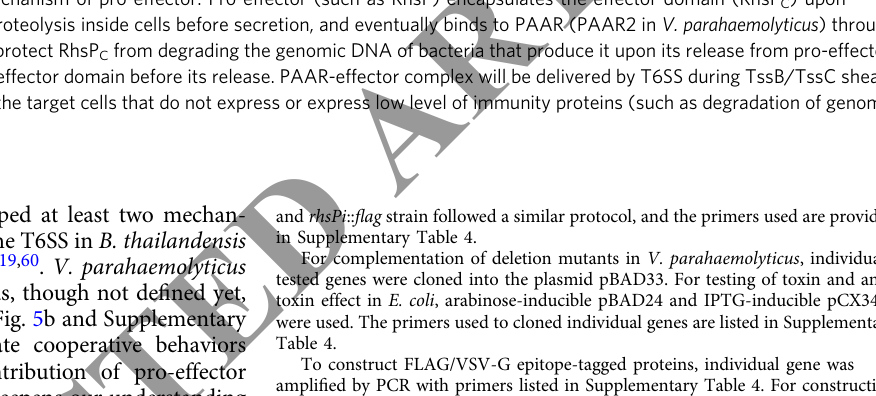
Table 4. To construct FLAG/VSV-G epitope-tagged proteins, individual gene was ampli fi ed by PCR with primers listed in Supplementary Table 4. For construction of plasmid expressing FLAG epitope-tagged protein, the PCR product of target